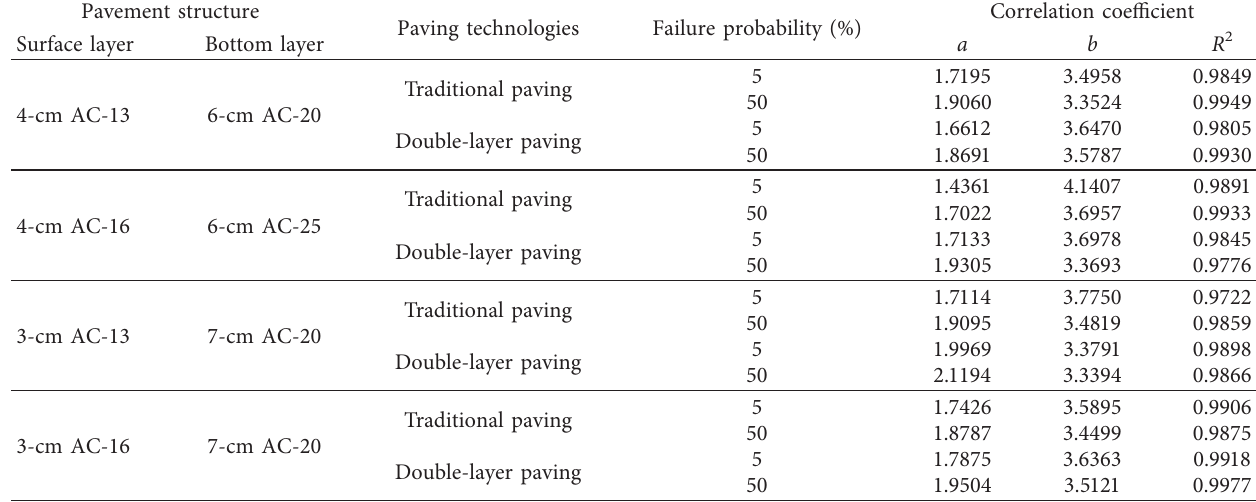
Table 8: Correlation coefficient of fatigue equation under different failure probabilities.